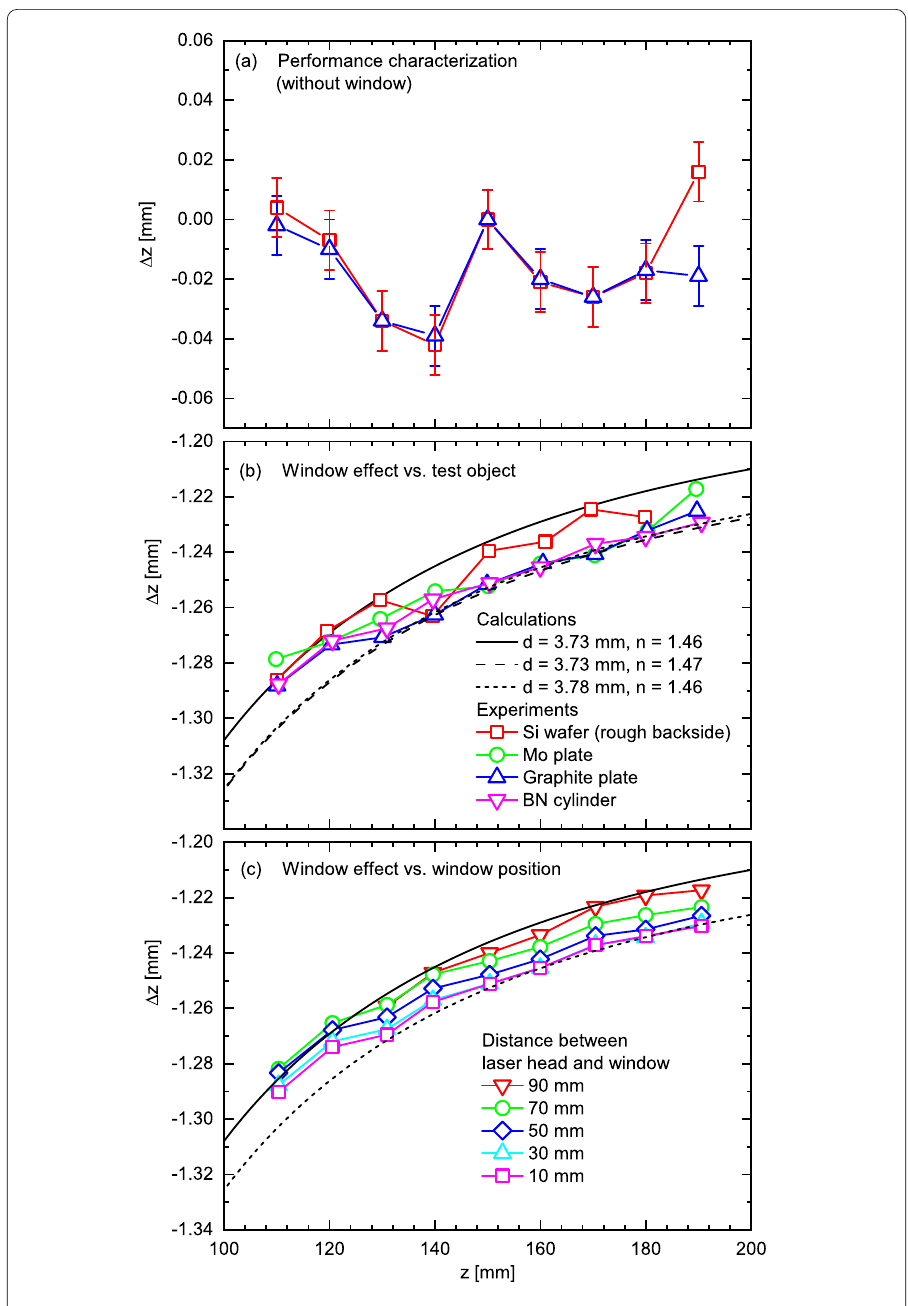
Figure 4 Performance characterization of the TLH. All data given in dependence on the set distance. Panel ( a ): Difference between measured distance and set distance. Panel ( b ): Difference of the measured distance with and without a glass window for various test object surfaces (distance between window and TLH: 30 mm). Panel ( c ): Difference of the measured distance with and without a glass window in dependence on the distance between window and TLH (test object: graphite plate). The solid and dashed lines represent calculation results according to Eq. (2). Parameters are given in the inset of panel ( b )